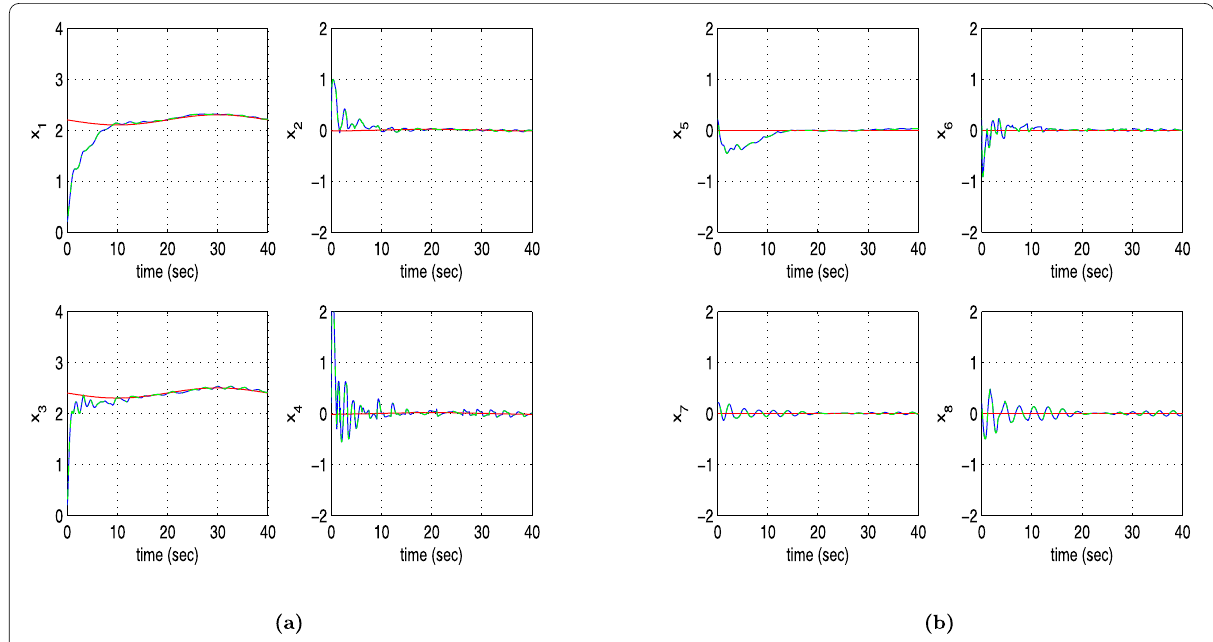
Figure 14 Tracking of setpoint 6 for the tower crane ( a ) control inputs u 1 , u 2 applied to crane, ( b ) tracking error variables e 1 , e 3 , e 5 , e 7 of the tower crane